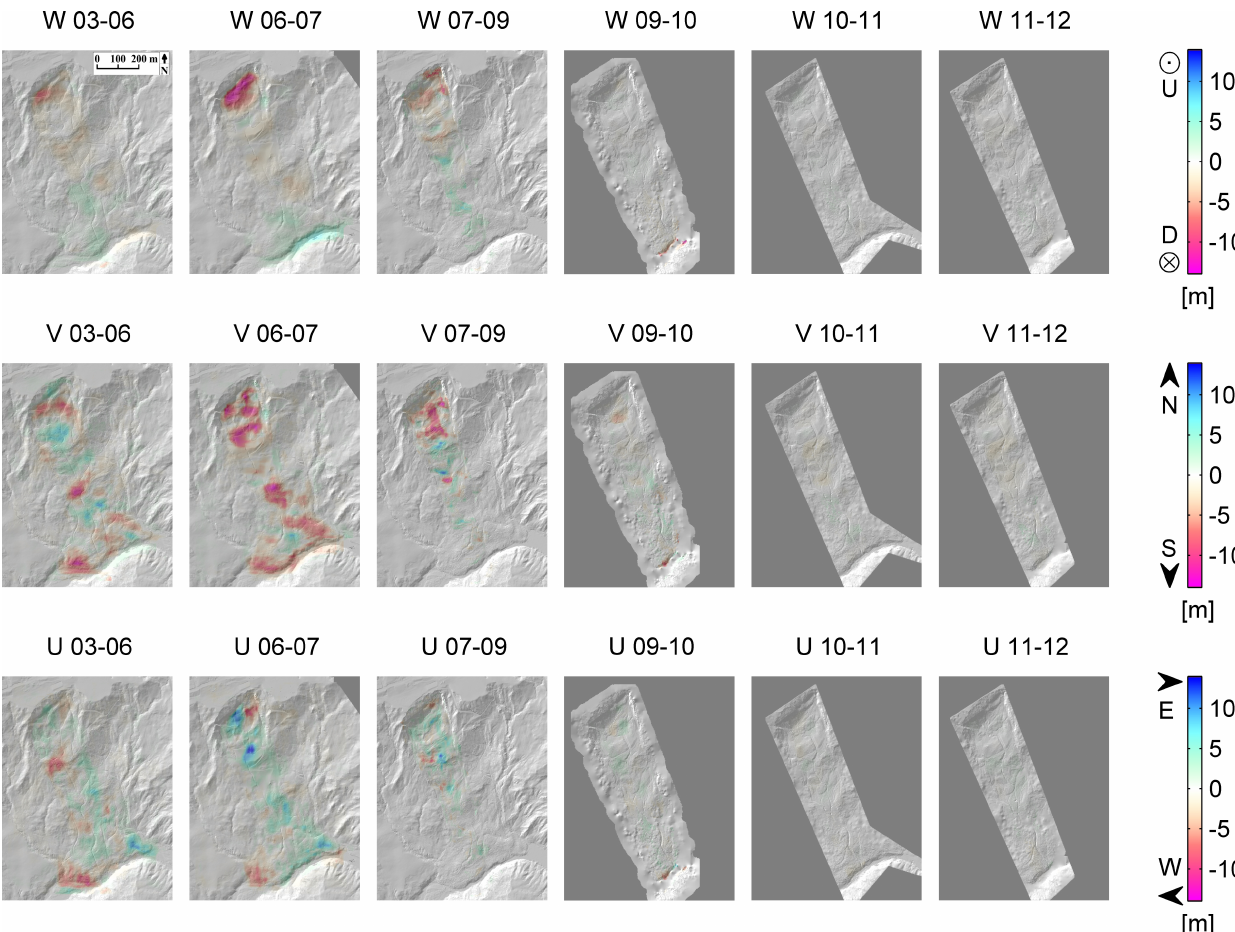
Figure 5. Motion vectors from 2003 to 2012. W . . . elevation change, U . . . west-east motion, V . . . south-north motion. Numbers indicate years in the form NN-MM, which denotes change from year 20NN to year 20MM. U = up (towards zenith), D = down (towards nadir). The same notation is followed throughout the